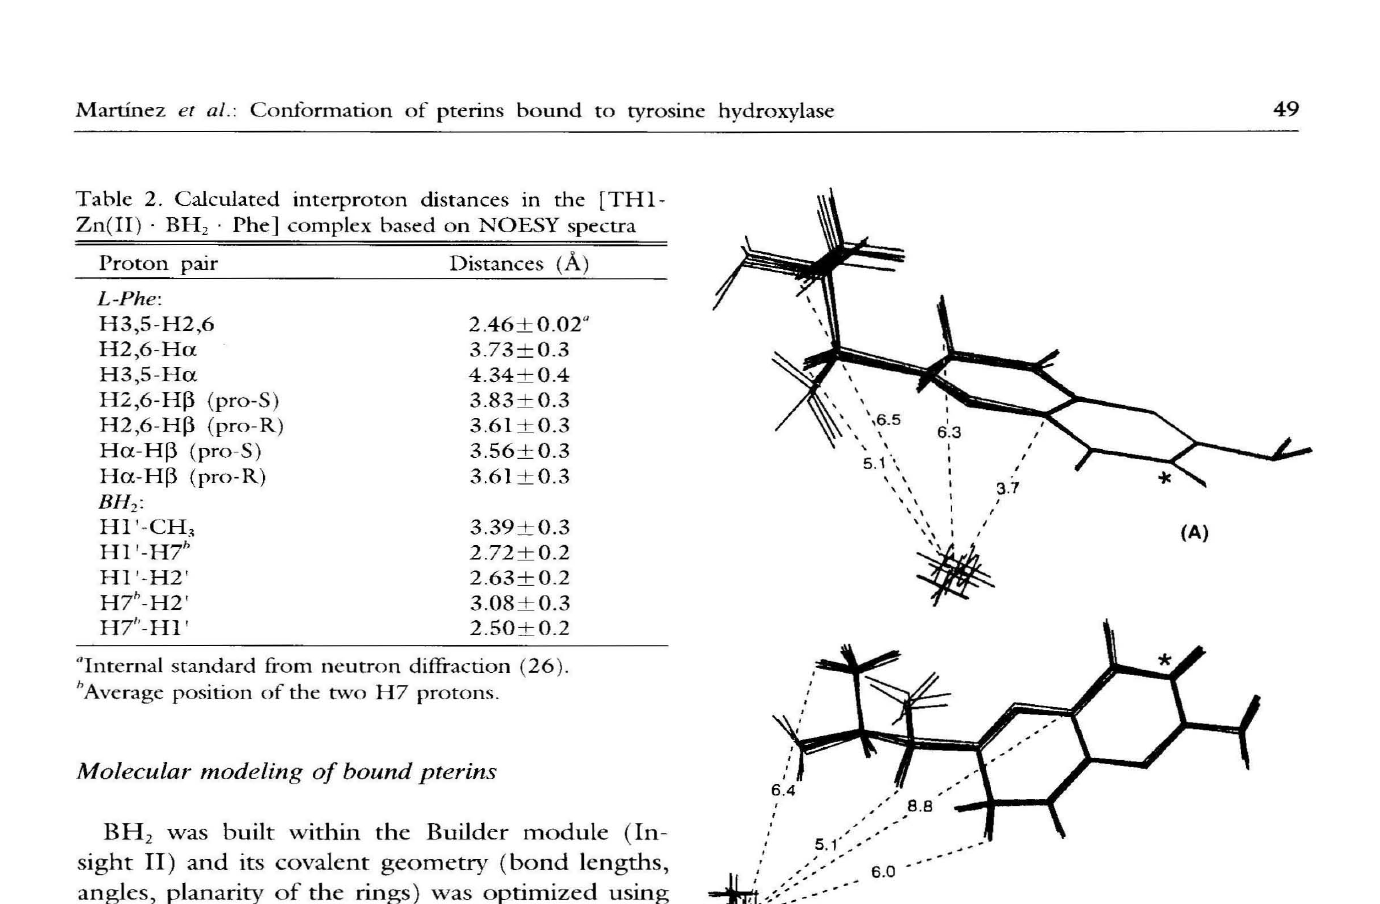
Figure 3. Conformations of L-erythro-7,8-dihydrobio pterin (BH,) bound at the active site of metal(Co(II) or Zn(II»-reconstituted THI based on the experimental dis tances given in Tables I and 2. Family A (A) and family B (B), shorter and longer distance from the pteridin ring to the metal ion, respectively (see Results), with the dis tances to the metal (in A) for one conformer in each fam ily. The asterisk shows the position of the